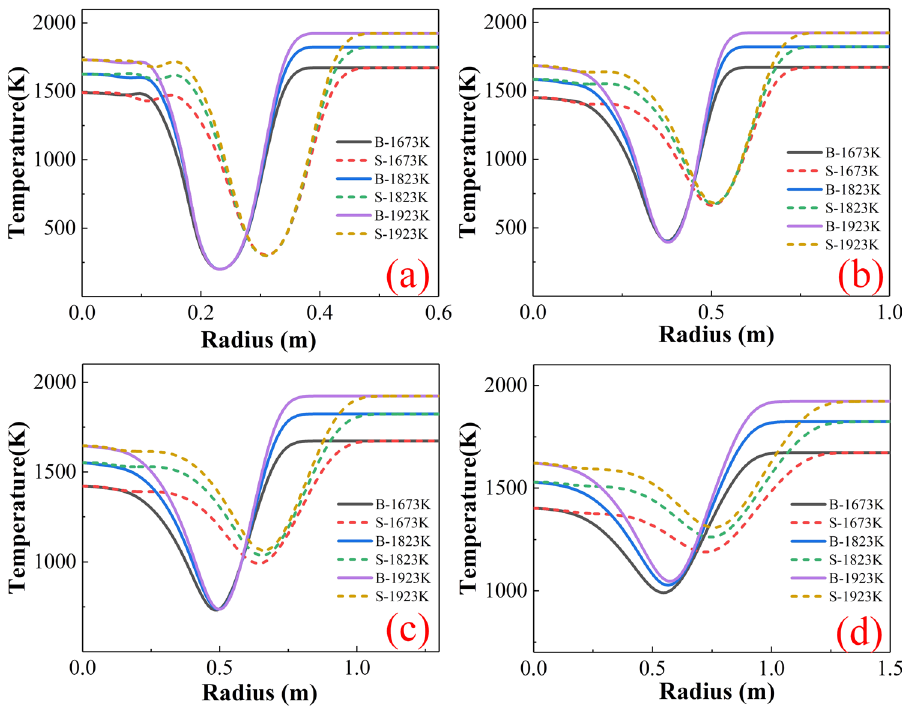
Figure 8: Radial temperature distribution of the jet under di ff erent temperature conditions: ( a ) 600 mm, ( b ) 1,300 mm, ( c ) 2,000 mm, and ( d ) 2,700